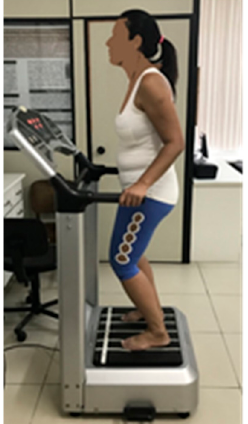
Figure 1. Patient positioned and performing WBVE on a side-alternating vibrating platform. The peack to peack displacement (PPD) used in the protocols, in both groups, was indicated on the base of the VP (Figure 2), to each PPD, the distance in centimeters (cm) between the apices of the tibial malleolus was established: at 2.5 mm of PPD, the distance was of 3 cm; for 5.0 mm of PPD, the distance was 21 cm and for 7.5 mm of PPD, the distance was 39 cm.